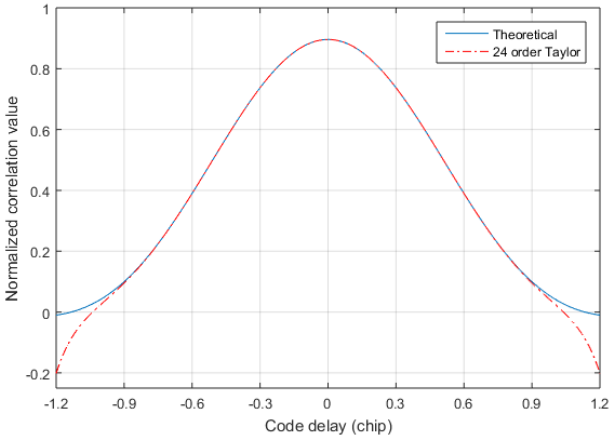
Figure 11. The correlation of 24-order Taylor and the theoretical correlation.